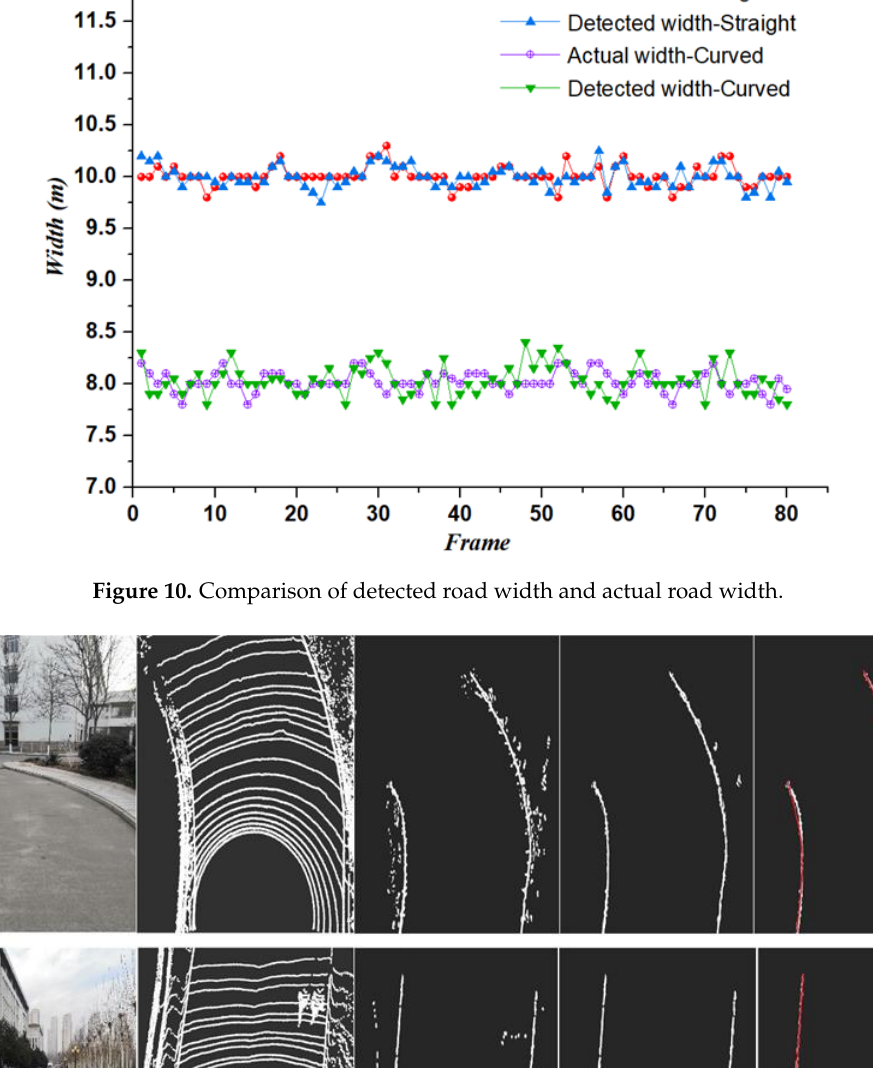
Figure 10. Comparison of detected road width and actual road width.